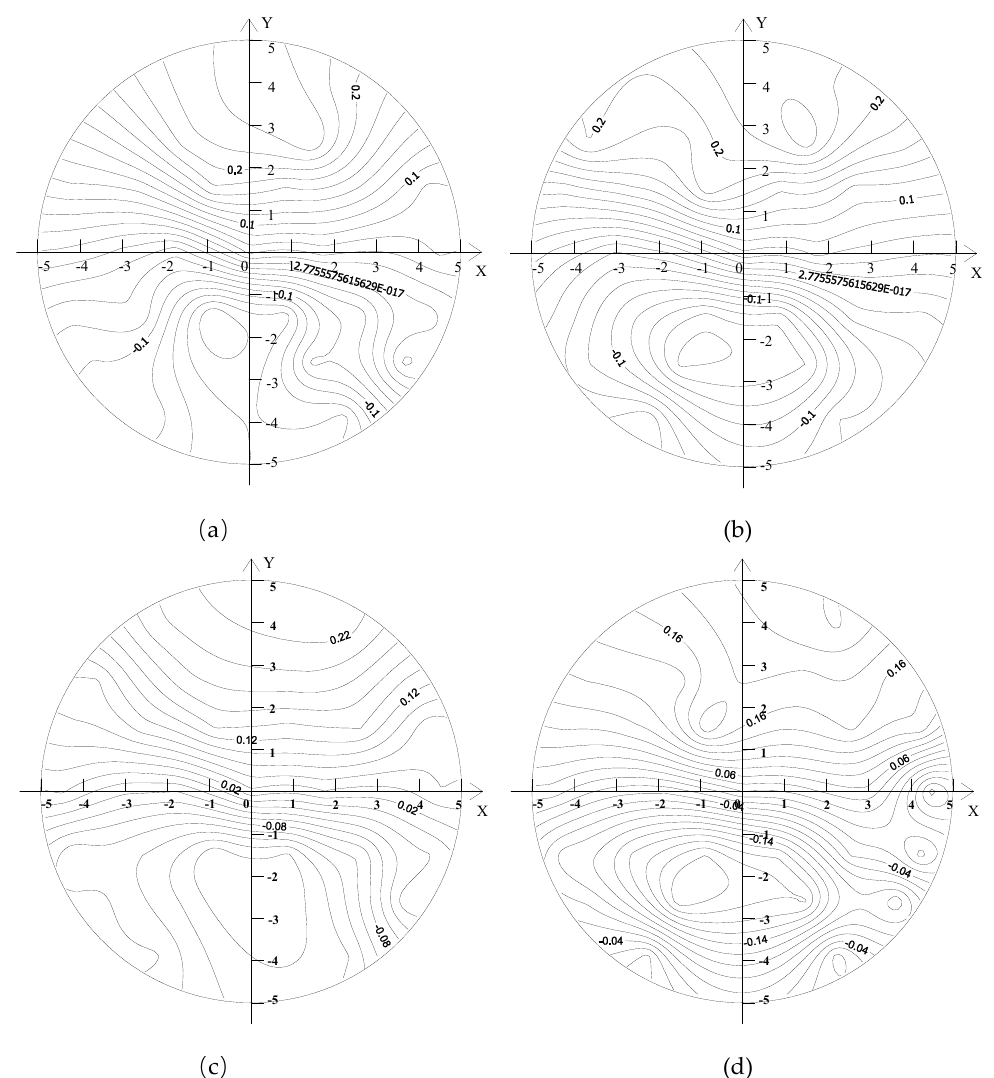
Figure 9. Circumferential velocity distribution of the downstream sections of capsules: ( a ) L / d = 2.5, Z = 0.2 m; ( b ) L / d = 2.14, Z = 0.2 m; ( c ) L / d = 2.5, Z = 3 m; and ( d ) L / d = 2.14, Z = 3 m.